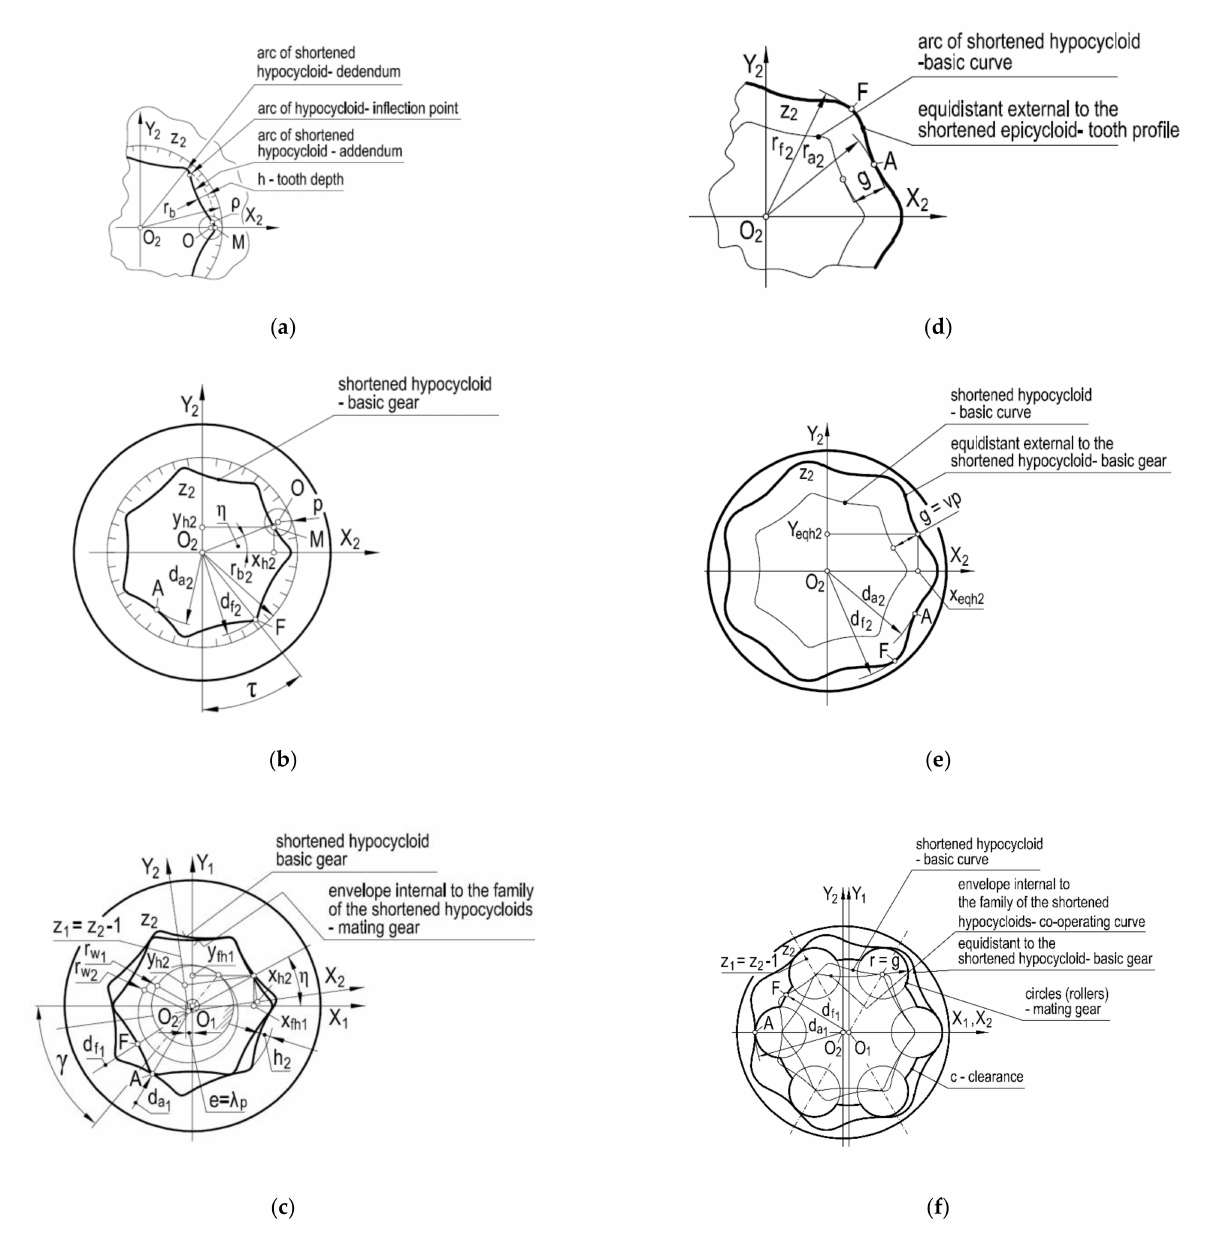
Figure 5. Design of teeth, gears and the internal hypocycloidal gear systems: ( a ) uncorrected teeth; ( b ) basic uncorrected internal gear; ( c ) mating uncorrected external gear; ( d ) corrected teeth; ( e ) basic corrected internal gear; ( f ) mating external corrected